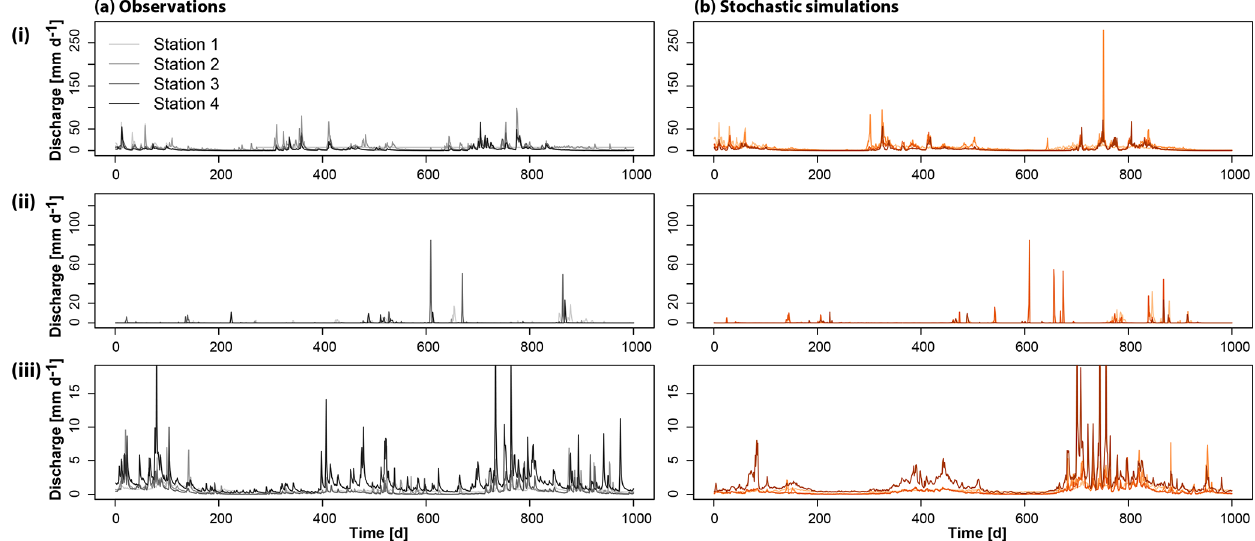
Figure 6. Comparison of 3 years of multi-site observations (a) with multi-site stochastic simulations (b) for the four catchments in the three example regions (i) Pacific Northwest, (ii) Texas, and (iii) Mid-Atlantic. Each region is displayed on its own